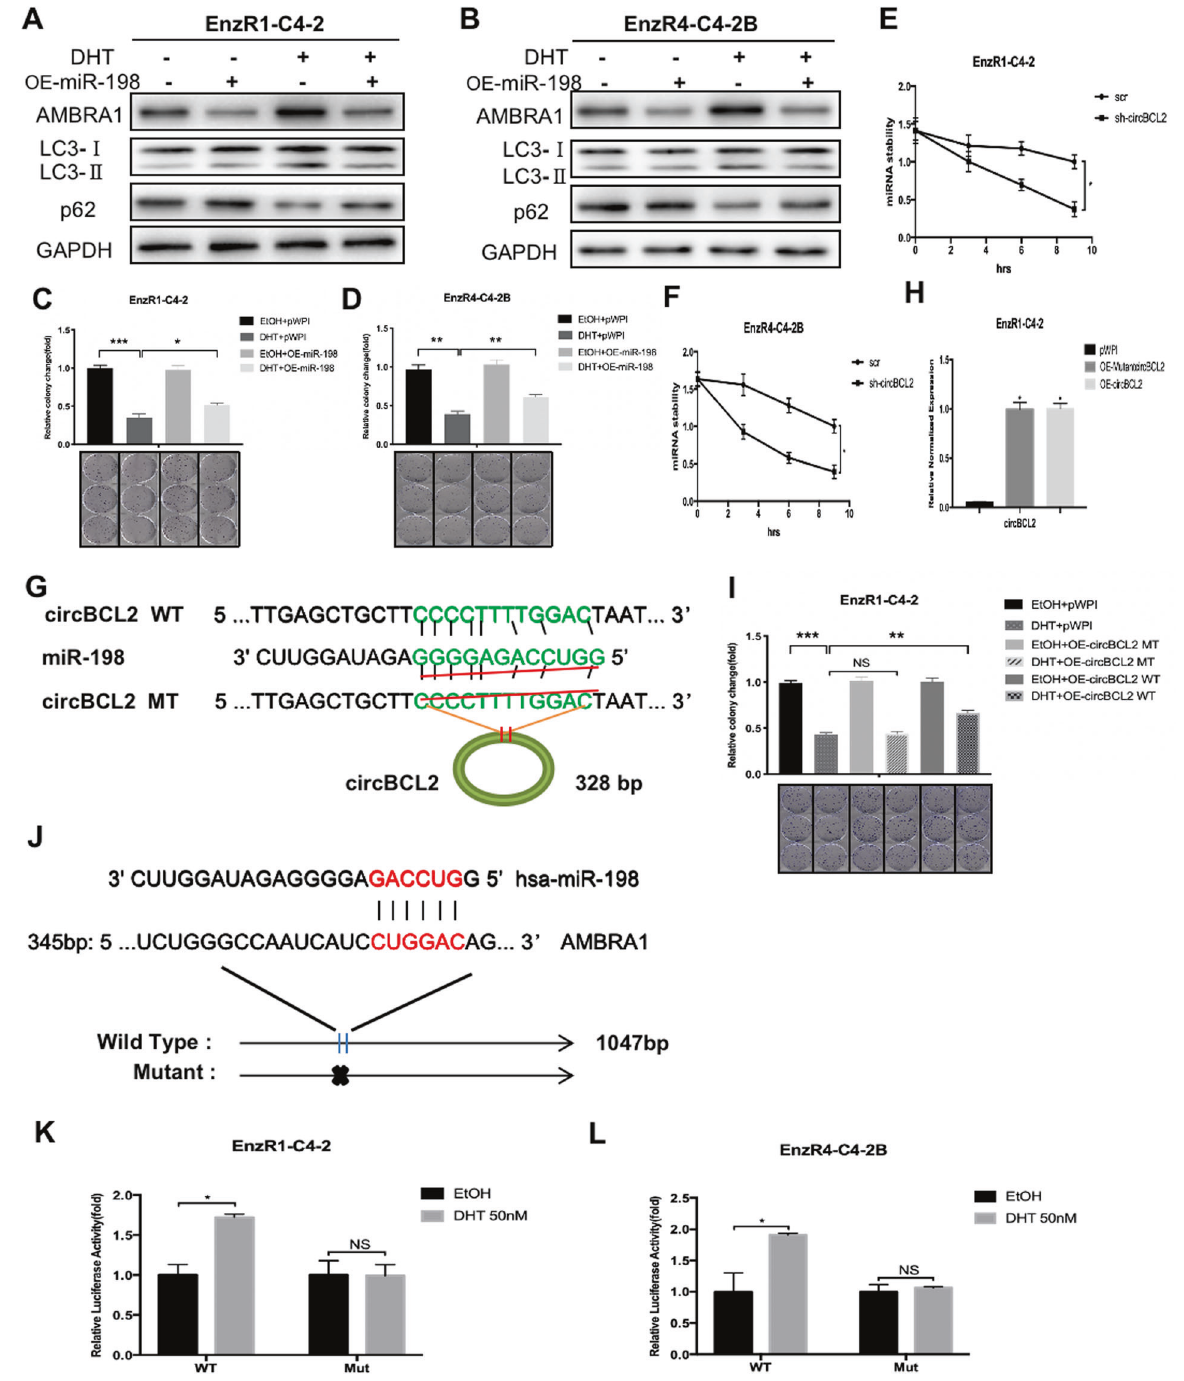
Fig. 5 Mechanism dissection of how DHT/circRNA-BCL2 alters the AMBRA1 expression in EnzR PCa cells: via regulating the miRNA-198 expression. A , B Western blot assays show AMBRA1, LC3 and p62 expression after OE-miRNA-198 (OE-miR-198) transduced in EnzR1-C4-2 ( A ) and EnzR4-C4-2B ( B ) cell lines with 50 nM DHT. C , D Colony formation assays show cell growth with 50 nM DHT when OE-miR-198 transduced in EnzR1-C4-2 ( C ) and EnzR4-C4-2B ( D ) cell lines. E , F The miR-198 stability was measured with the addition of 5 μ M Actinomycin D (ActD) in EnzR1-C4-2 ( E ) and EnzR4-C4-2B ( F ) cells with/without knocked-down circRNA-BCL2. G The circRNA-BCL2 with and without miR-198 binding sites (CircNet). H The qRT-PCR was performed to show quanti fi cation of circRNA-BCL2 after OE-mutantcircBCL2. I Colony formation assay shows decreased cell growth with 50 nM DHT and OE-mutant circRNA-BCL2 in EnzR1-C4-2 cell line. J The wild type (WT) and mutant (Mut) AMBRA1 luciferase constructs. K , L Luciferase activity after transfection of WT or Mut AMBRA1 3 ’ -UTR with 50 nM DHT treatment in EnzR1-C4-2 ( K ) and EnzR4-C4-2B ( L ) cell lines. Data are presented as means ± SD. * p < 0.05, ** p < 0.01, *** p < 0.001, NS not signi fi cant.